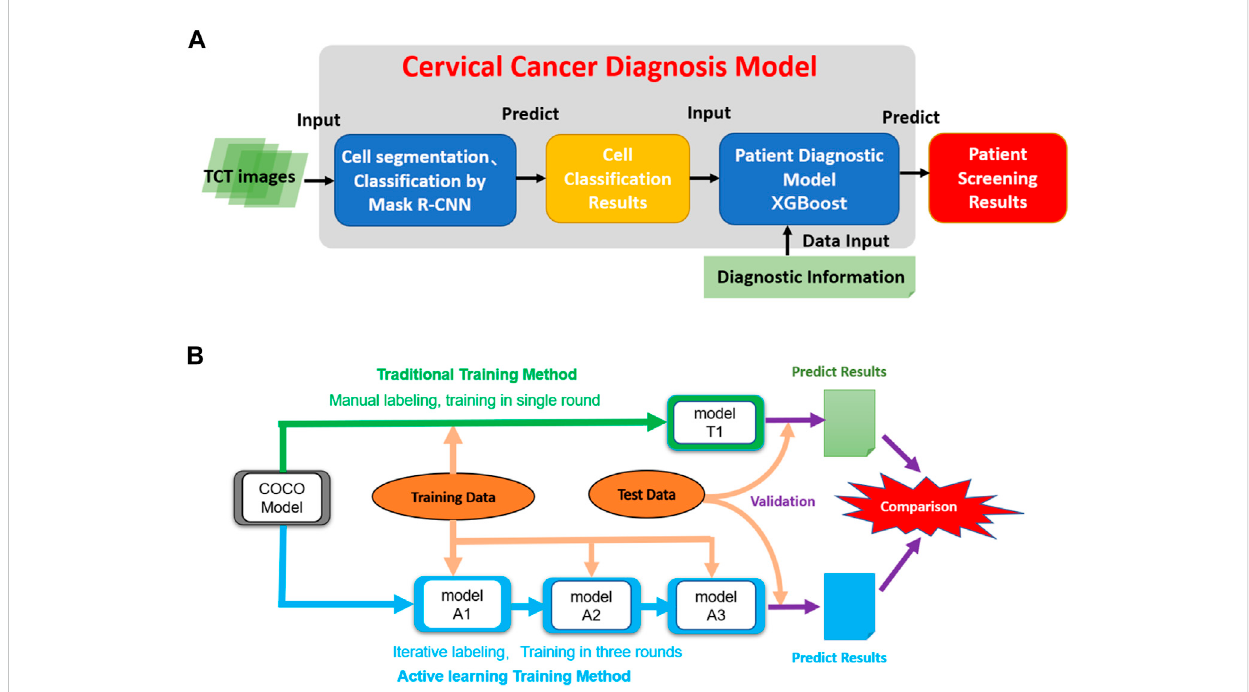
FIGURE 1 The architecture of the model and the data fl ow of the project. (A) The architecture of the cervical cancer diagnosis model. It takes TCT images as inputs and then performs cell segmentation and classi fi cation. Then the cell classi fi cation results combined with related clinic diagnostic information are used to do patient classi fi cation. (B) The data process work fl ow of this project. The initial COCO DCNN model was trained using traditional and active learning methods. Then two fi nal cell segmentation/classi fi cation models (T1 and A3) were evaluated and compared to each